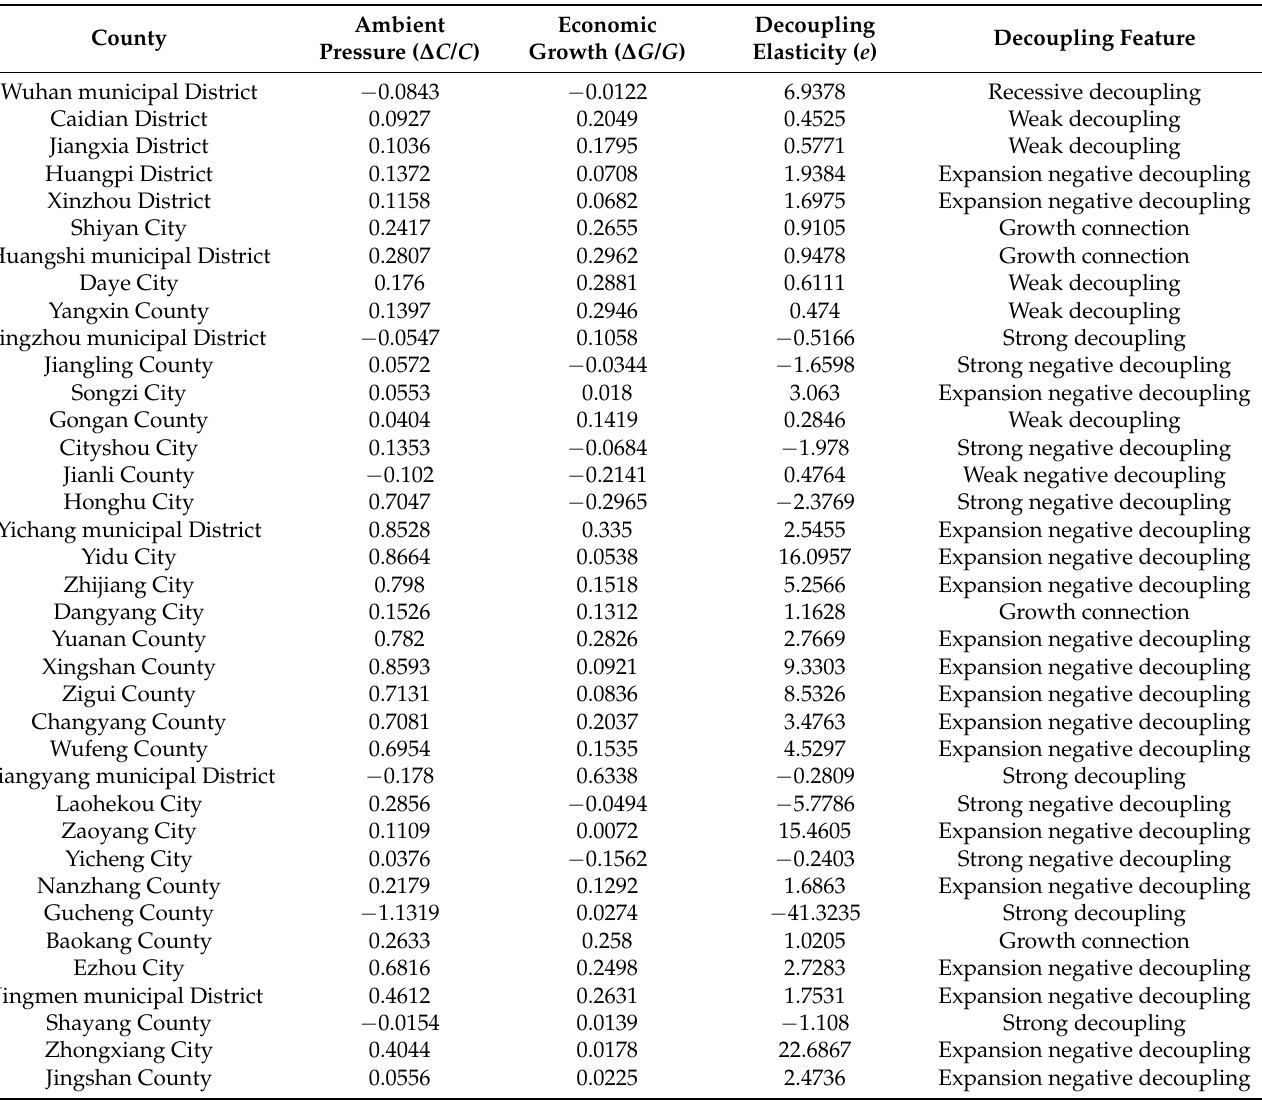
Table A1. Decoupling characteristics of carbon emissions and agricultural economic growth from 2000 to